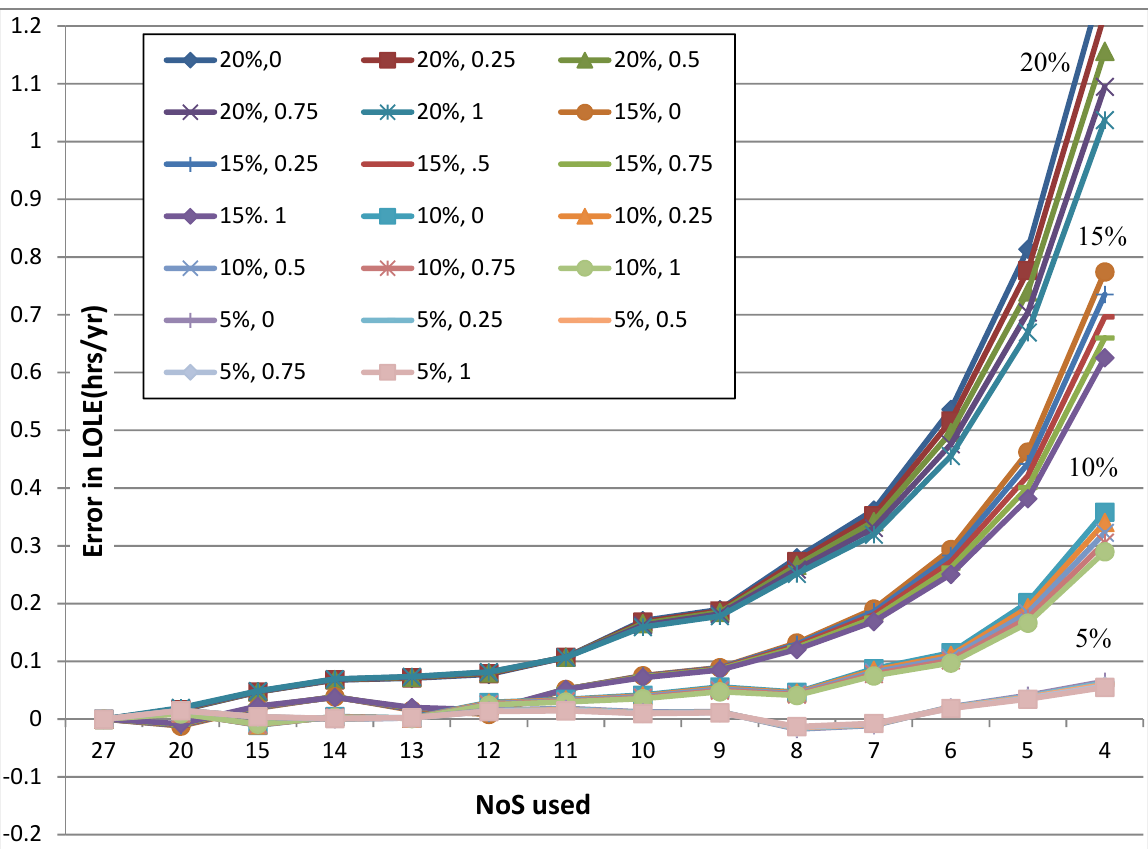
Figure 10. Error produced by using reduced number of states in the Wind Capacity model.